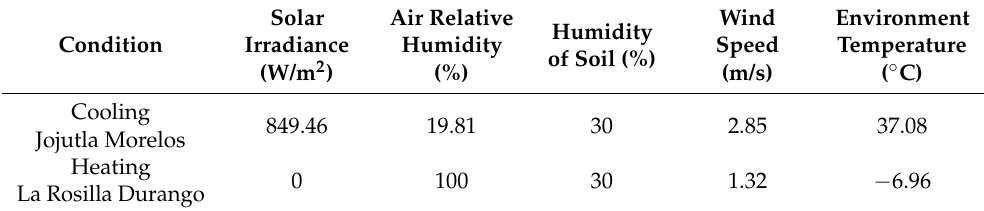
Table 9. Climatological conditions for modelling of the